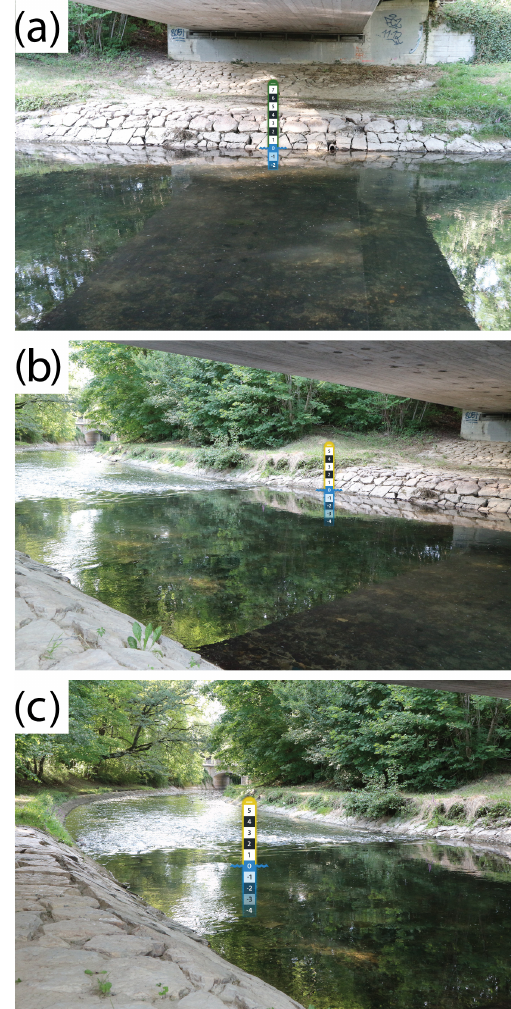
Figure 3. Examples of staff gauge placements: (a) 13 points, i.e., a full score; (b) 10 points, just enough points to still be considered suitable for future water level observations; and (c) 3 points, the lowest score obtained throughout the